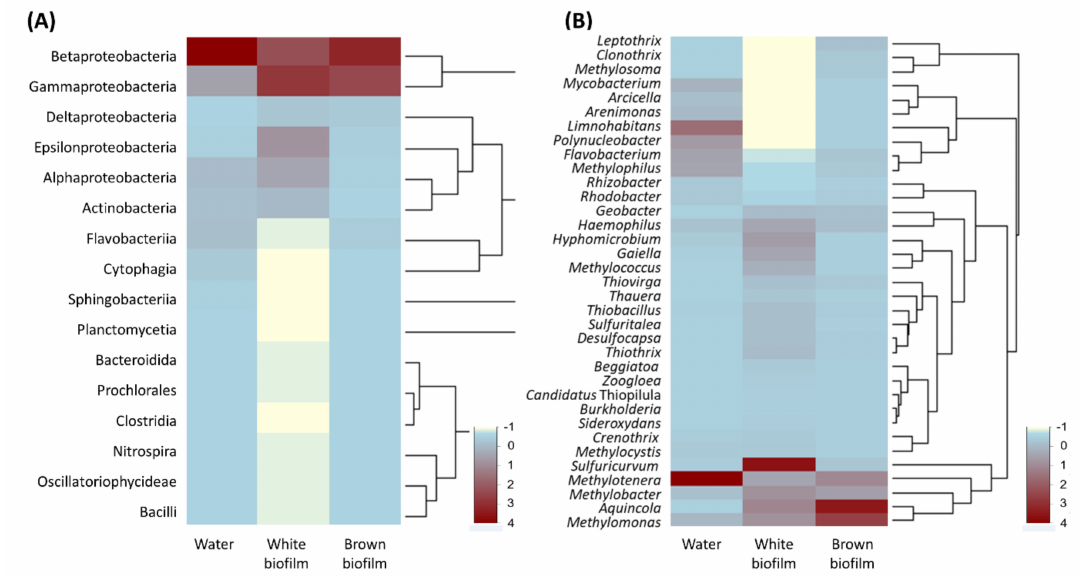
Figure 7. Heat map analysis of the relative abundance of members of prokaryotic communities in water, white biofilm, and brown biofilm in the Smrdljivec spring, at class ( A ) and genus ( B ) level. Listed are all phylotypes detected at class level and phylotypes whose relative abundance at genus level was >0.5% in at least one of the